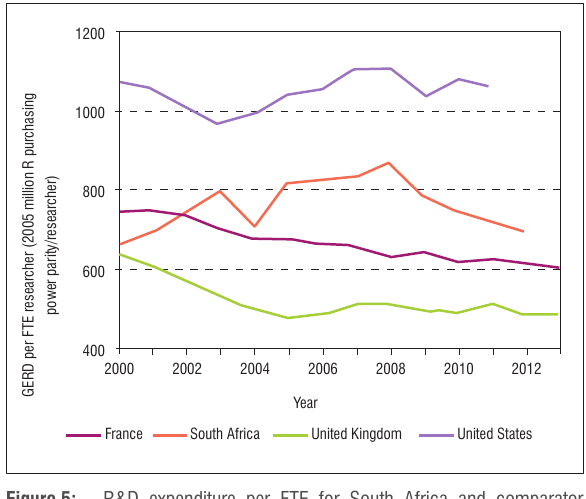
Figure 5: R&D expenditure per FTE for South Africa and comparator countries.